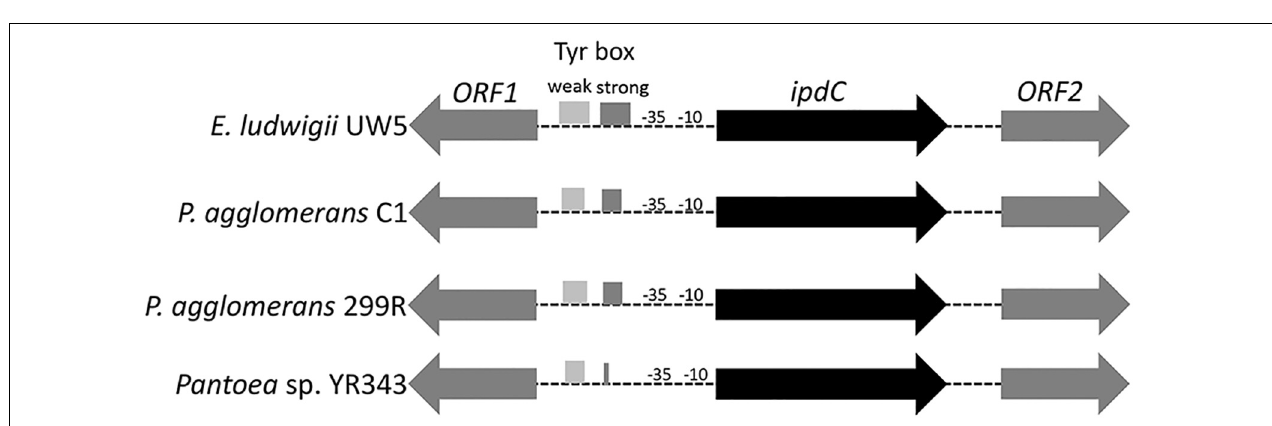
FIGURE 3 | Organization of the chromosome region surrounding ipdC across different species. The boxes in the ipdC promoter region indicate the location of the sequences with partial similarity to the two TyrR binding boxes occurring in E. ludwigii EW5. The predicted -10 and -35 elements for ipdC gene are also